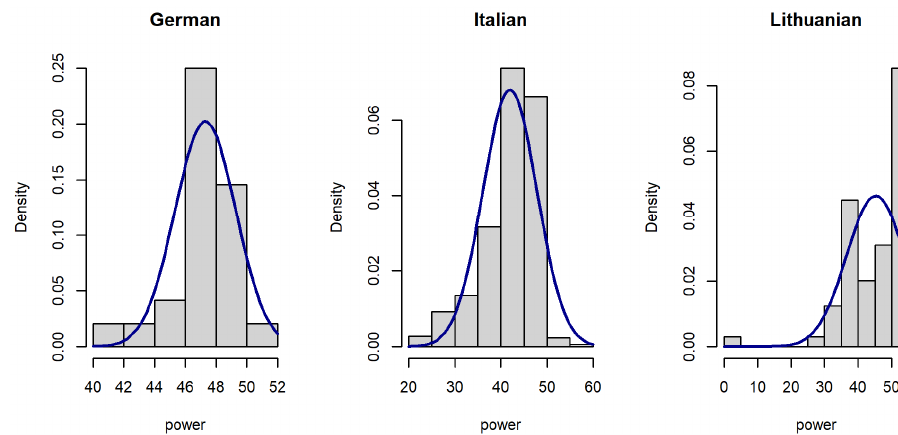
Figure 2. Histograms of voice signal power in datasets.